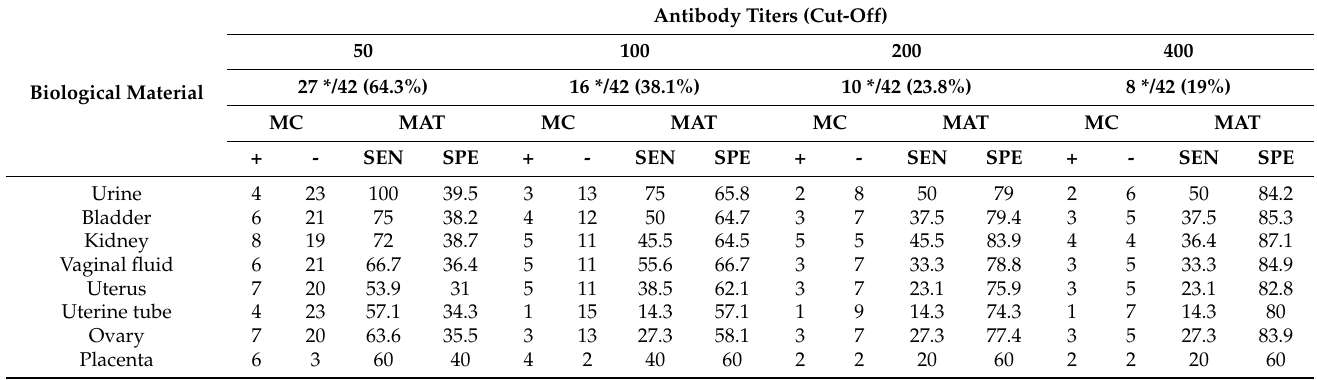
Table 5. Performance of different MAT cut-offs using microbiological culture as gold standard per biological